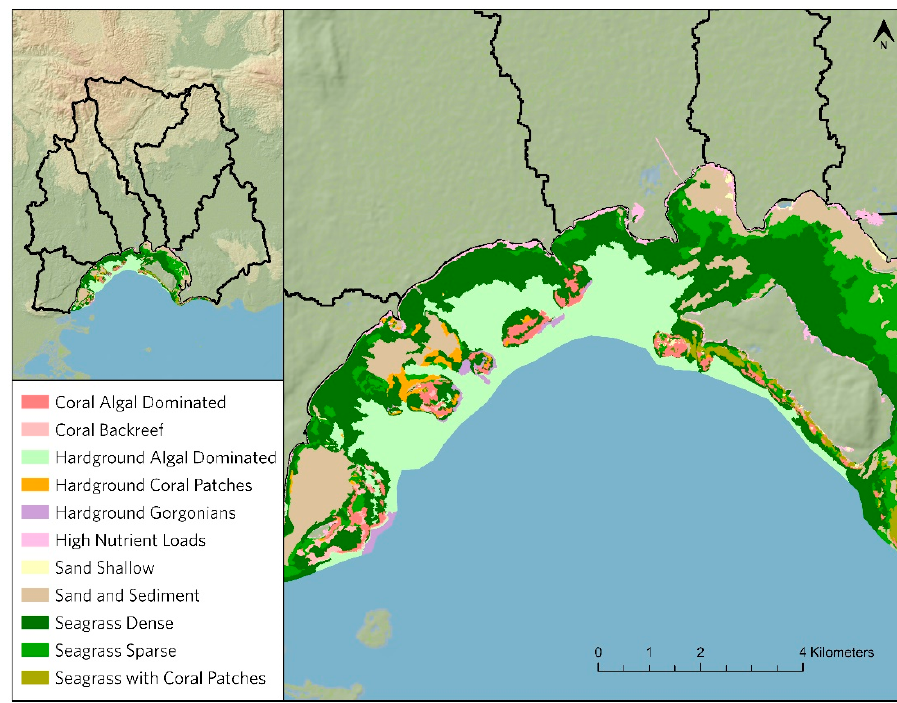
Figure 2. Watershed boundaries modeled using RiverTools v4 and NASADEM elevation (30 m) that indicate drainage patterns into the Old Harbour Bay community and surrounding bay. An 11-class marine benthic habitat classification was derived from WorldView-3 satellite imagery (1.25 m, acquired on 23 October 2018) and GPS-referenced underwater field data.